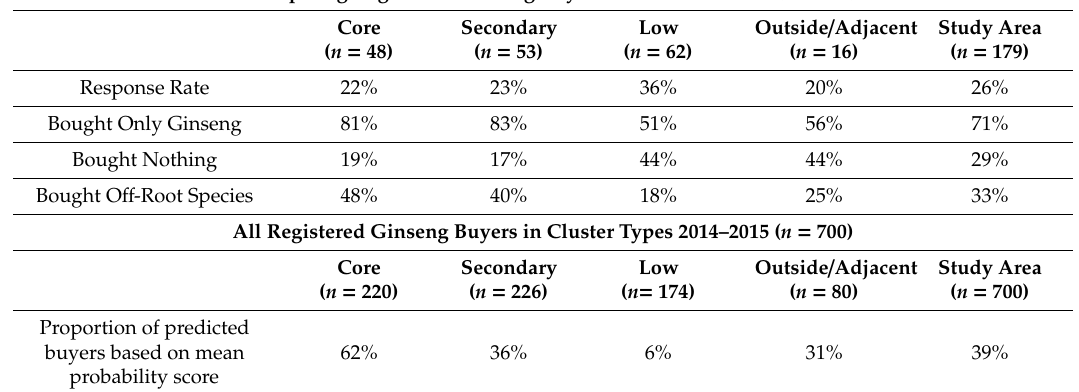
Table 6. Purchasing frequency and probability for purchasing o ff -roots among surveyed ginseng buyers. The first section of the table presents results for observed purchasing by respondents among cluster types (i.e., whether respondents bought ginseng, bought o ff -roots, or bought nothing during the study period). The second section lists the proportion of all licensed ginseng buyers in the study area ( n = 700).